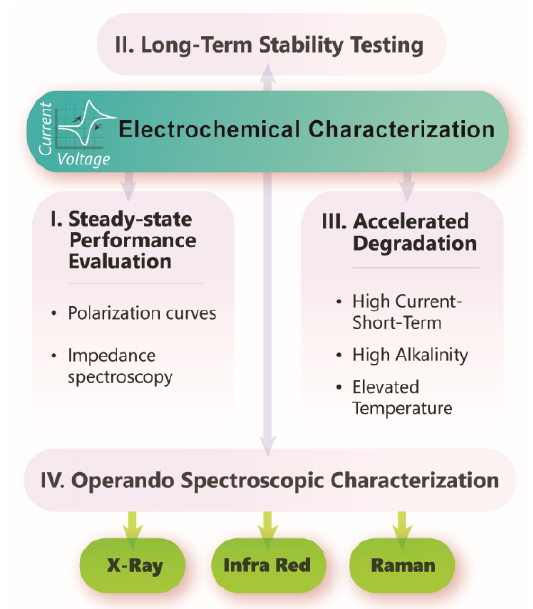
Figure 6. Aspects of electrochemical characterization techniques to be leveraged to improve the de- velopment and understanding of